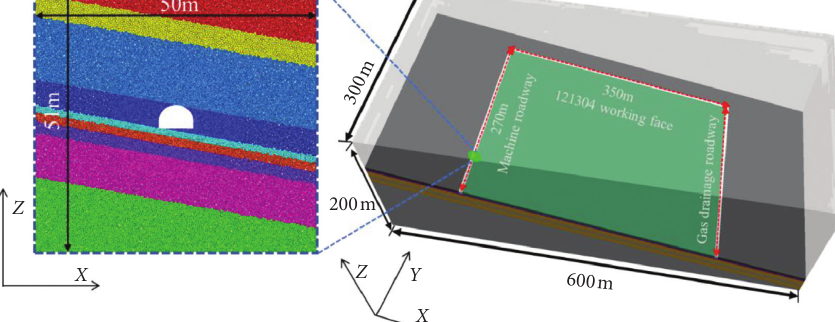
Figure 15: Global-local